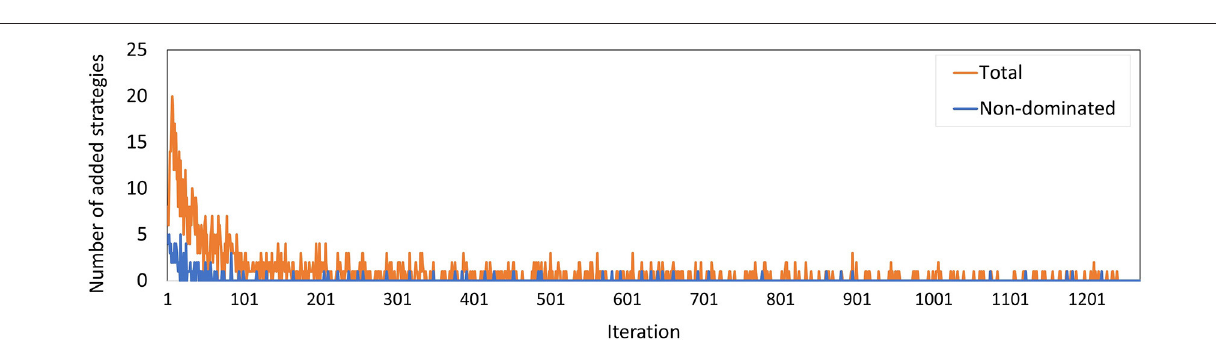
FIGURE 9 | The number of policies added to the memory in each iteration for Experiment 2. The blue line counts all added policies, the orange line only those that are not dominated by (combinations of) other policies in the current memory. The latter are part of the minimal representation of the memory’s approximation